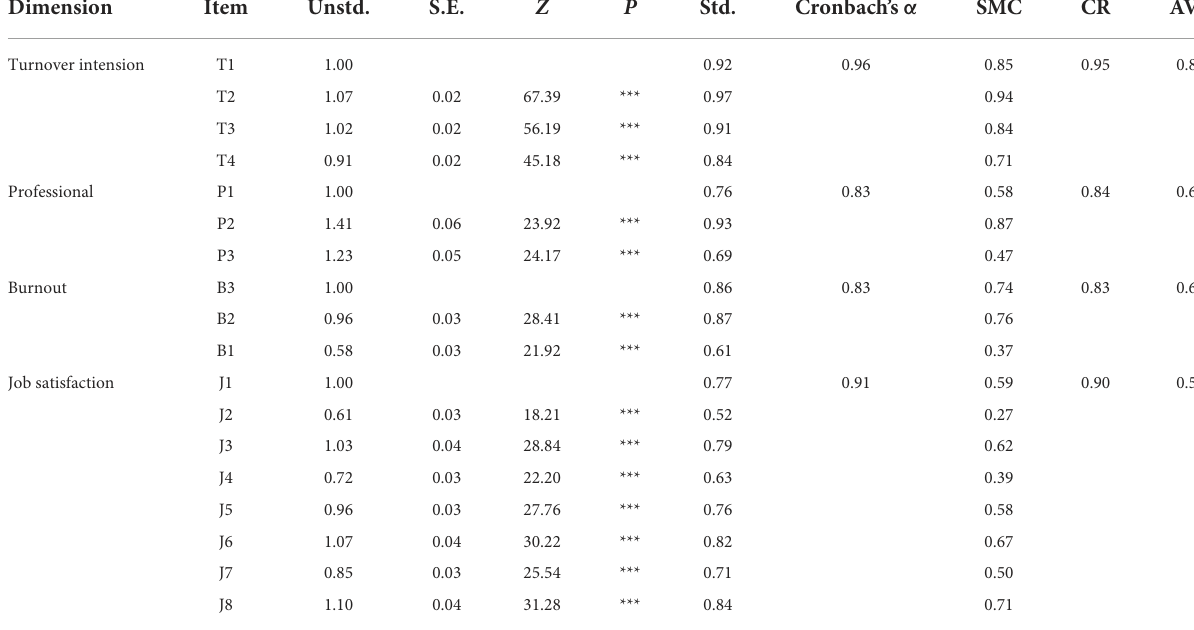
TABLE 2 Reliability and validity